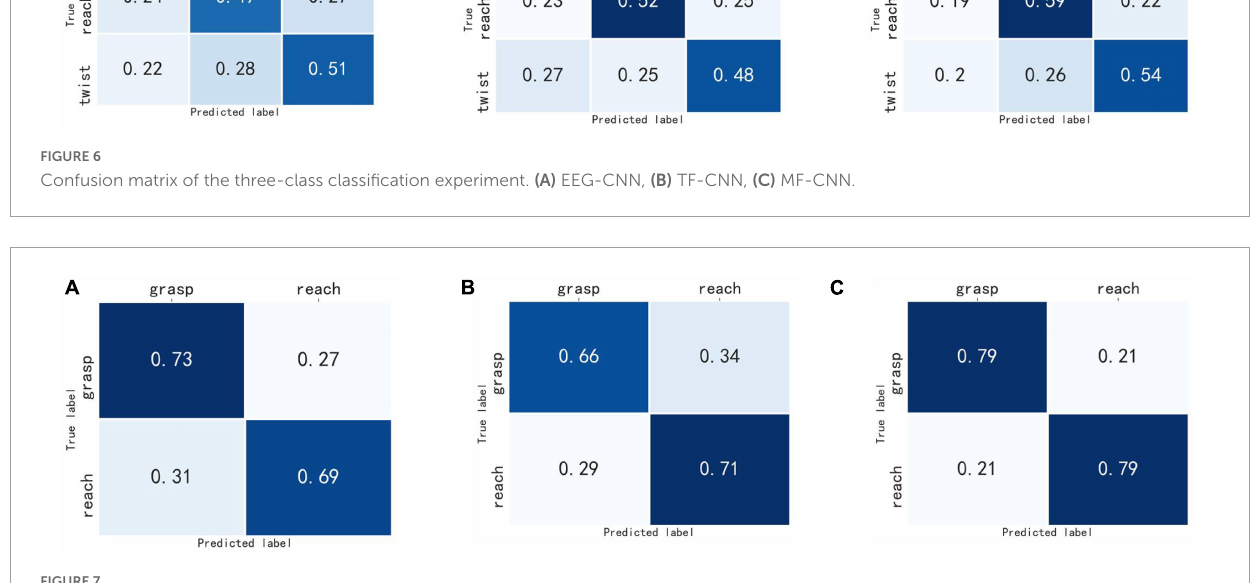
FIGURE7 Confusion matrix of the binary-class classification experiment. (A) EEG-CNN, (B) TF-CNN, (C) MF-CNN.